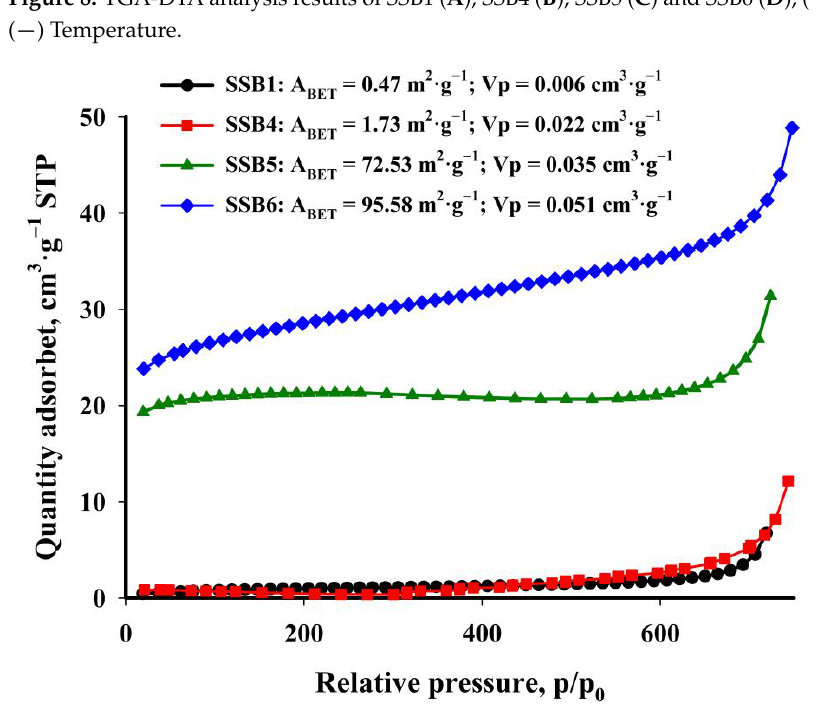
Figure 9. N 2 adsorption isotherm of selected studied biochars.